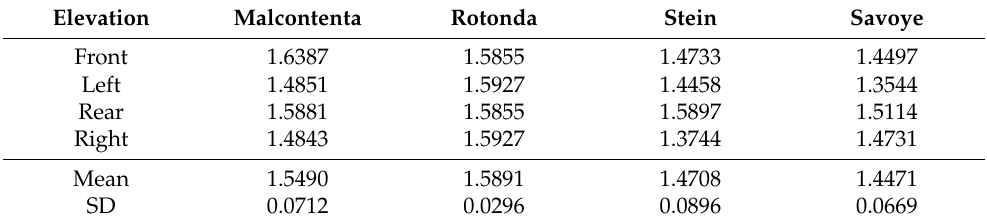
Table 1. D values of